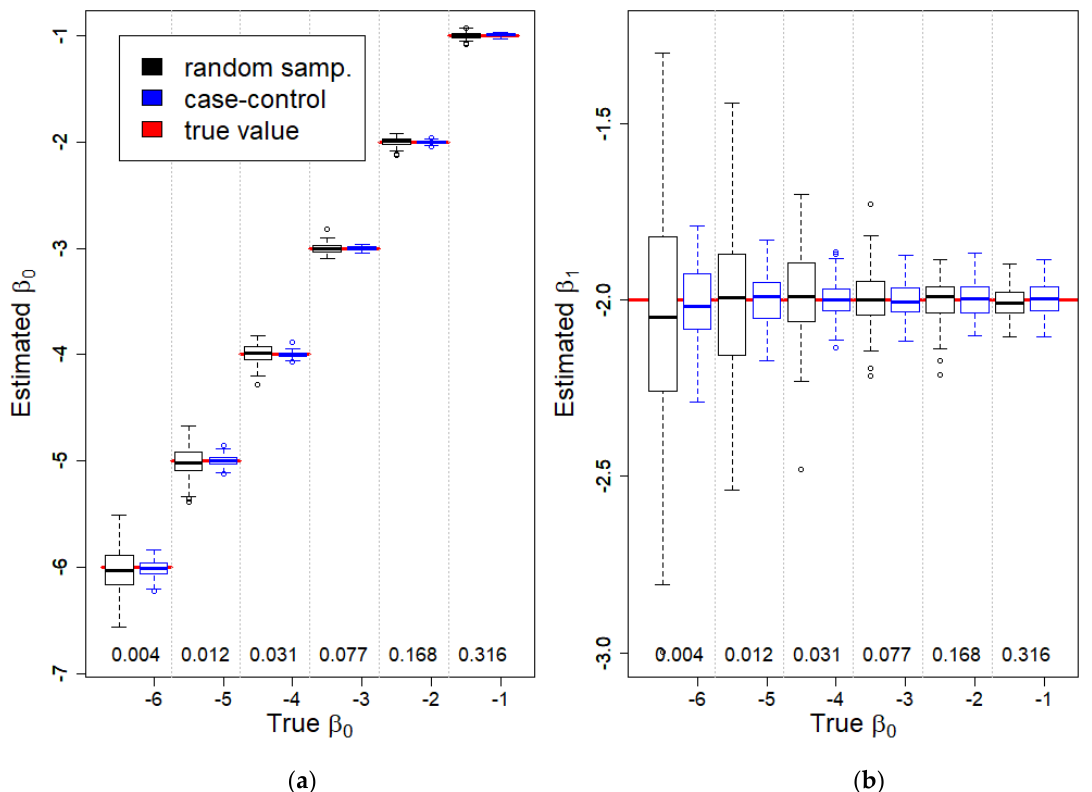
Figure 3. Data sampled using a case-control (CC) approach yielded unbiased estimates of logistic regression parameters (intercept β 0 and slope β 1 ) and will generally yield more precise estimates when compared to data sampled using a random sampling (RS) approach. Panels ( a ) and ( b ) display the estimated intercepts and slope parameters, respectively. True parameter values are represented by thick horizontal red lines and estimated parameters based on simulated datasets originating from the RS and CC control approaches are shown with black and blue boxplots, respectively. The average proportion of cases in the original dataset before sampling took place is given by the numbers at the bottom. Results are based on 100 simulated datasets for each value of true β 0